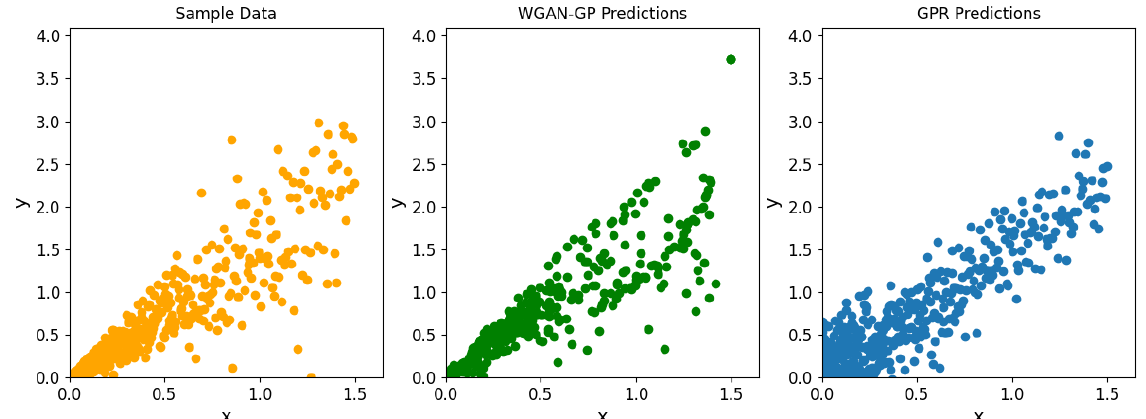
Figure 5. Heteroscedastic dataset. The test data is shown on the left, sampled points from the WGAN are shown in the middle and sampled points from the GPR posterior are shown on the right.